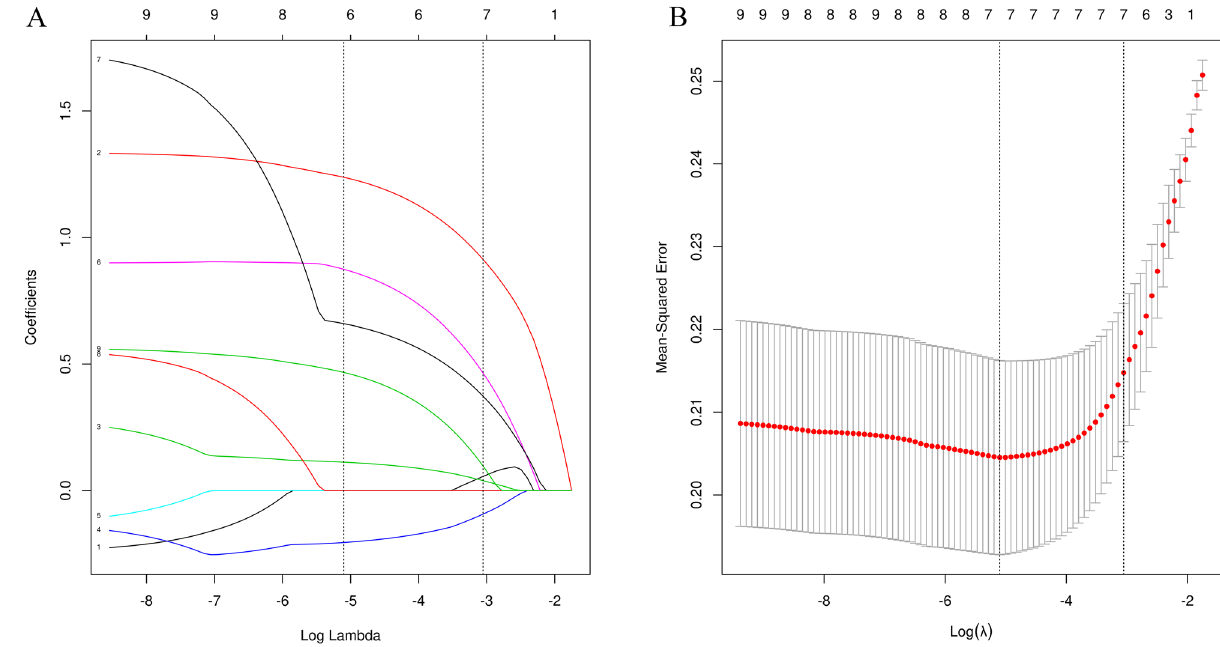
Figure 3. LASSO regression results for risk variables. ( A ) coefficient path diagram of risk variables; ( B ) cross- validation curve of LASSO regression.